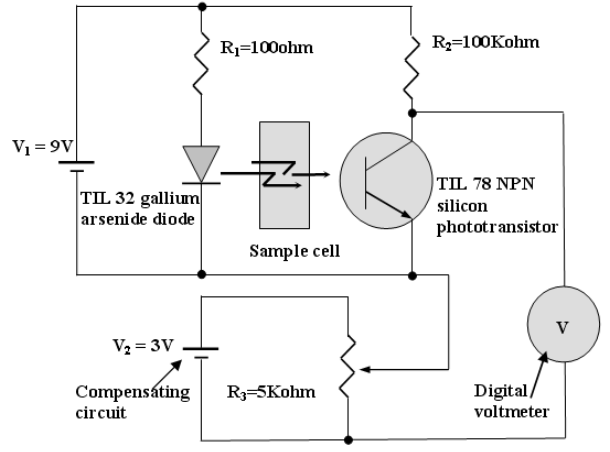
Figure 4. Schematic design of a simple turbidimeter